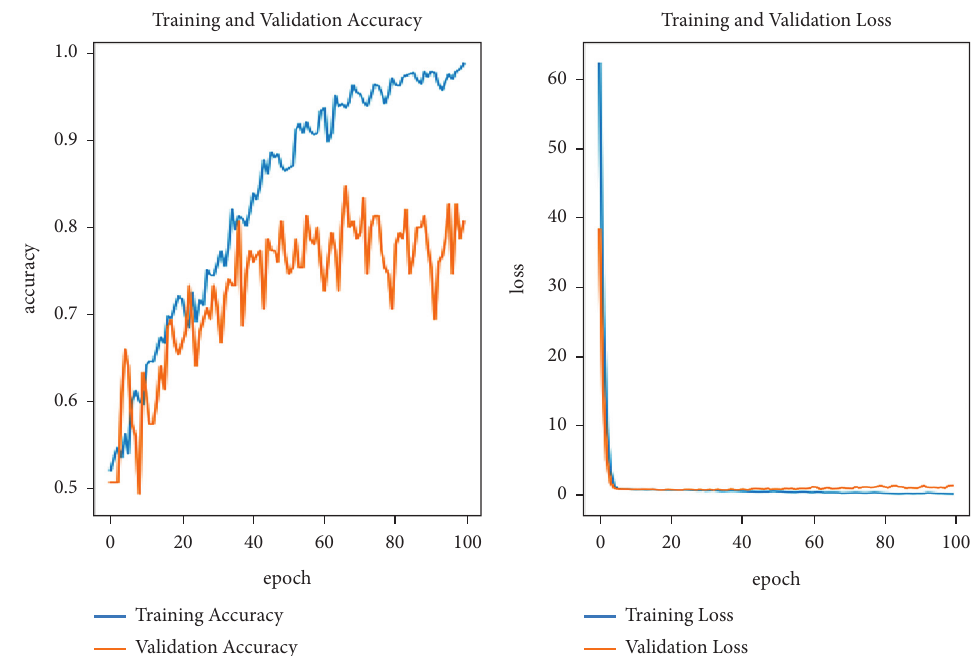
Figure 8: Accuracy and loss of the custom CNN model.